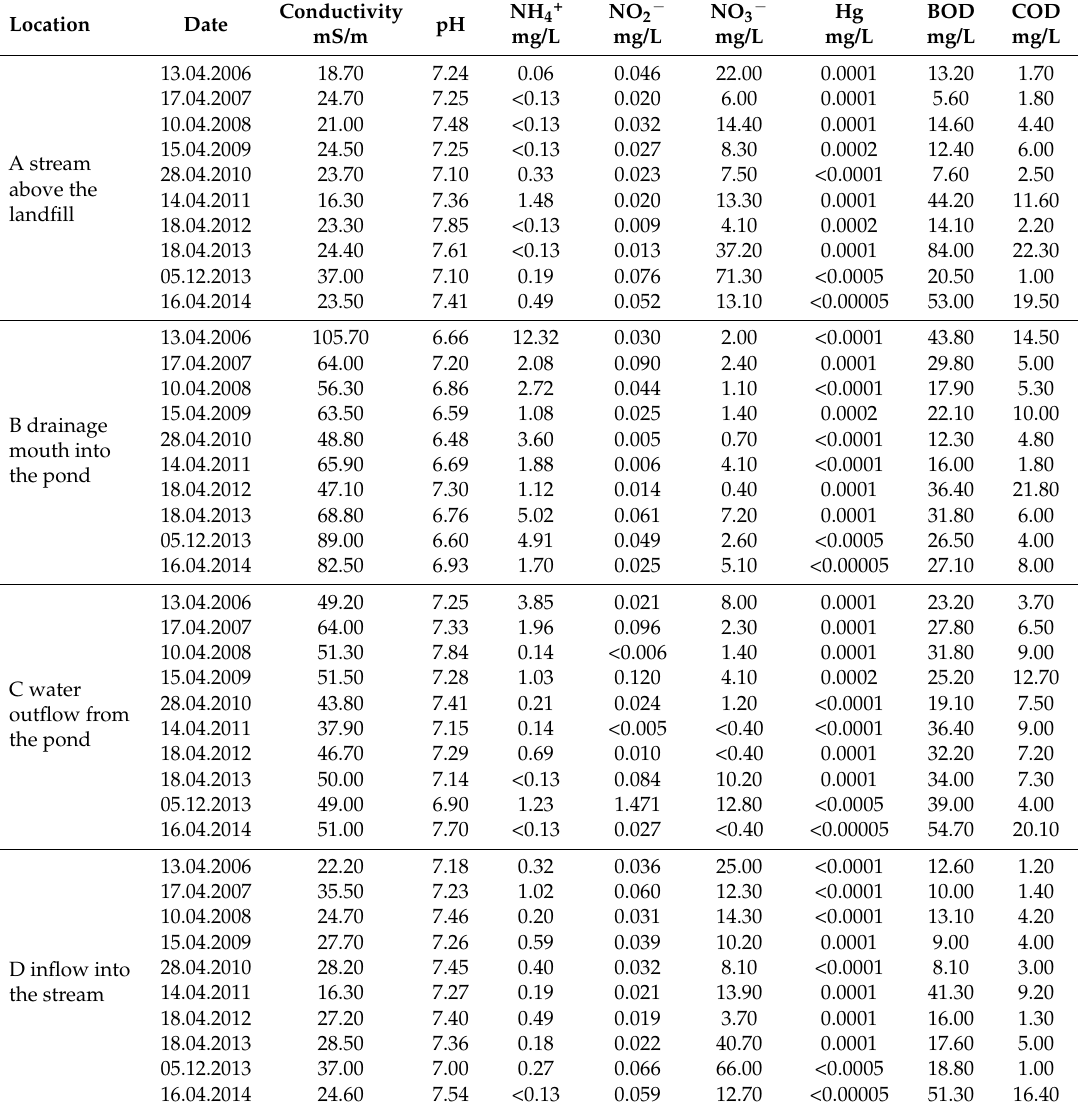
Table 3. Overview of selected results of surface water quality monitoring during the period of 2006–2014.